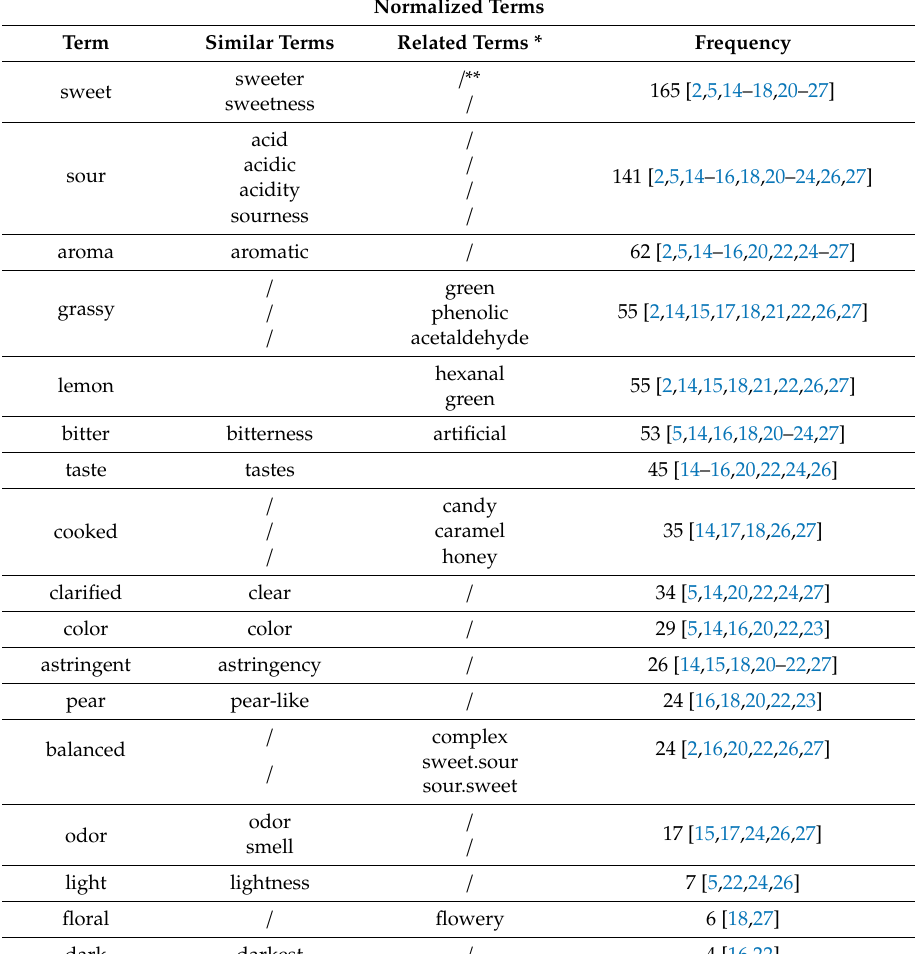
Table 2. Selected terms that underwent the normalization process with similar and related